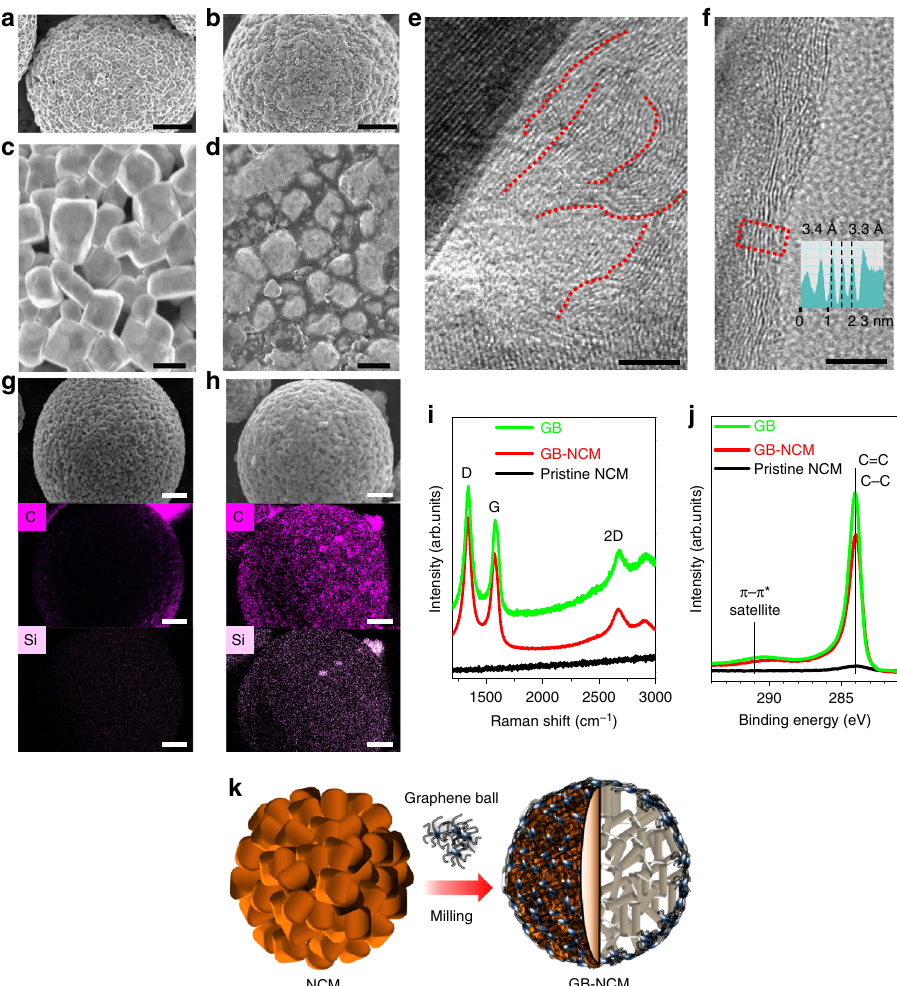
Fig. 3 Coating of GB onto LiNi 0.6 Co 0.1 Mn 0.3 O 2 . SEM images of LiNi 0.6 Co 0.1 Mn 0.3 O 2 a , c before (scale bars, 2 µ m and 200 nm, respectively) and b , d after GB coating (scale bars, 2 µ m and 200 nm, respectively). e , f TEM images of graphene sheets (scale bars, 5 nm). e Located between primary particles of LiNi 0.6 Co 0.1 Mn 0.3 O 2 and f coated along primary particles of LiNi 0.6 Co 0.1 Mn 0.3 O 2 . g , h EDX elemental mapping of LiNi 0.6 Co 0.1 Mn 0.3 O 2 with respect to C and Si (scale bars, 2 µ m). g Before and h after GB coating. i Raman spectra of GB, pristine LiNi 0.6 Co 0.1 Mn 0.3 O 2 and GB-coated LiNi 0.6 Co 0.1 Mn 0.3 O 2 . j XPS spectra of the same three samples in C 1s branch. k Schematic illustration of the GB coating onto LiNi 0.6 Co 0.1 Mn 0.3 O